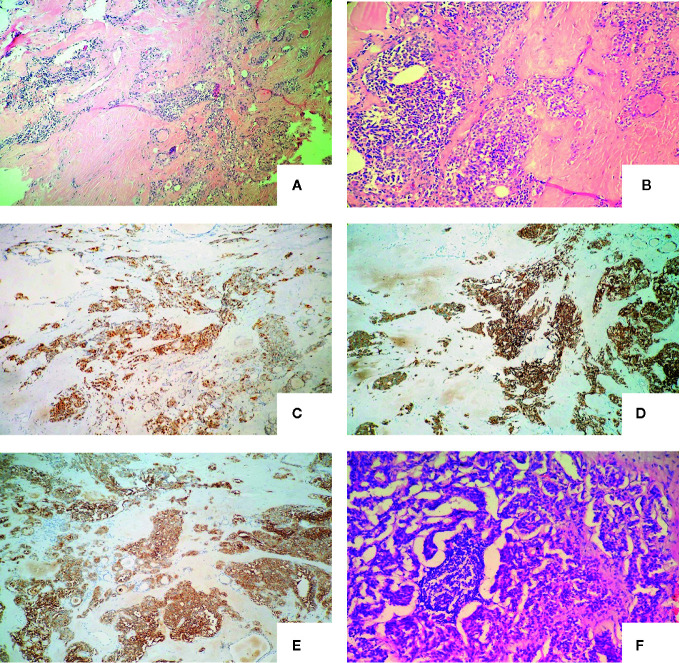
Definitive pathology of the thyroid tissue and lymph nodes of the first operation with the microscopy and immunochemistry evaluation: (A) The nests of neoplastic cells were separated by thick septa of fibrous tissue (haematoxylin and eosin, original magnification, x 100); (B) Amyloid deposits around the cell nest (haematoxylin and eosin, original magnification, x 200); (C) Neoplastic cells were strongly immunoreactive for chromogranin A (immunoperoxidase stain for anti-chromogranin A, original magnification, x 100); (D) Neoplastic cells were strongly immunoreactive for synaptophysin (immunoperoxidase stain for anti- synaptophysin, original magnification, x 100); (E) Neoplastic cells were strongly immunoreactive for carcinoembryonic antigen (immunoperoxidase stain for anti- carcinoembryonic antigen, original magnification, x 100); (F) Central lymph node metastasis. (haematoxylin and eosin, original magnification x 200).